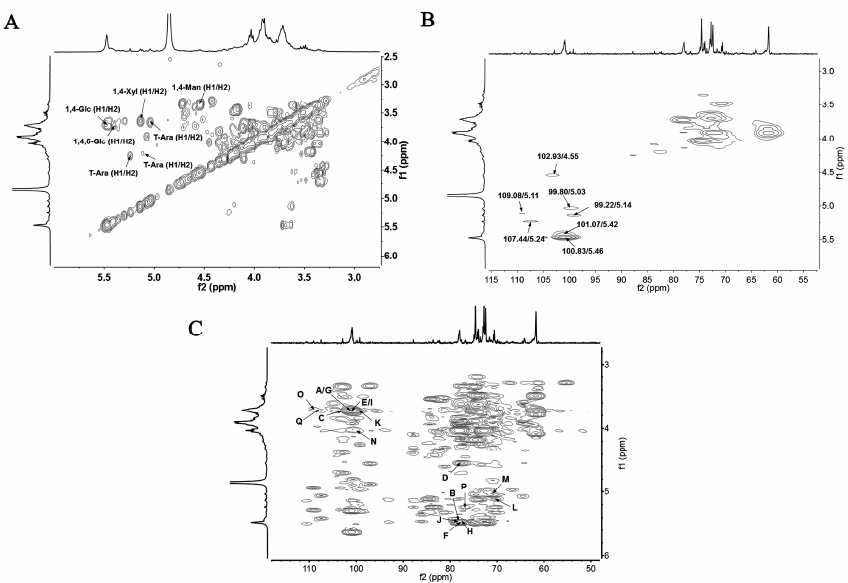
Figure 3. Two-dimensional spectra of JCS1. ( A ) Proton ( 1 H)- 1 H correlation spectroscopy (COSY); ( B ) heteronuclear single-quantum correlation (HSQC); and ( C ) heteronuclear nuclear multi-bond correlation HMBC spectra.